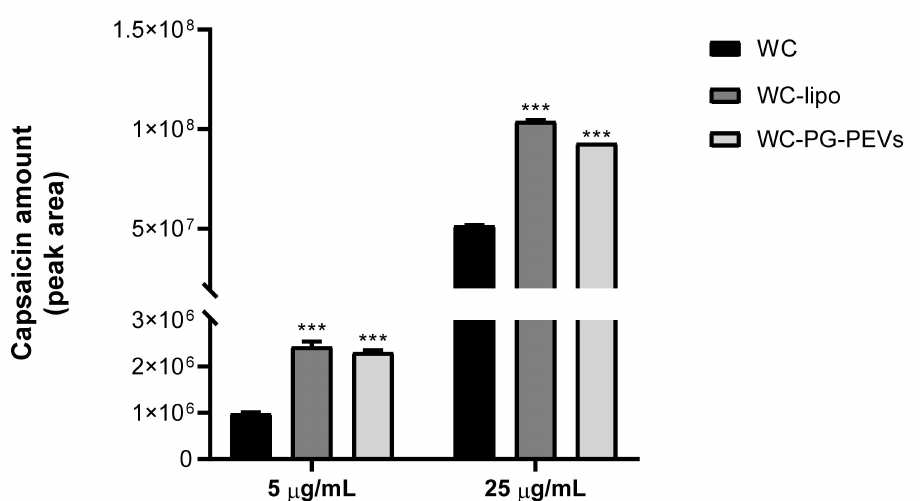
Figure 5. Amount of white Capsicum extract, reported as an area of the chromatographic peak of capsaicin, accumulated in U937/PMA cells as free or incorporated into liposomes and PG-PEVs. Two different concentrations of the extract were tested (5 µ g/mL and 25 µ g/mL). Results are reported as means of three independent replicates ± S.D. ( n = 3). Statistical significance of differences was determined by using Student’s t -test, *** p < 0.001 (5 µ g/mL WC-lipo vs. 5 µ g/mL WC, 5 µ g/mL WC PG-PEVs vs. 5 µ g/mL WC, 25 µ g/mL WC-lipo vs. 25 µ g/mL WC, and 25 µ g/mL WC PG-PEVs vs. 25 µ g/mL WC). Abbreviations: WC, free WC; and WC-lipo, WC